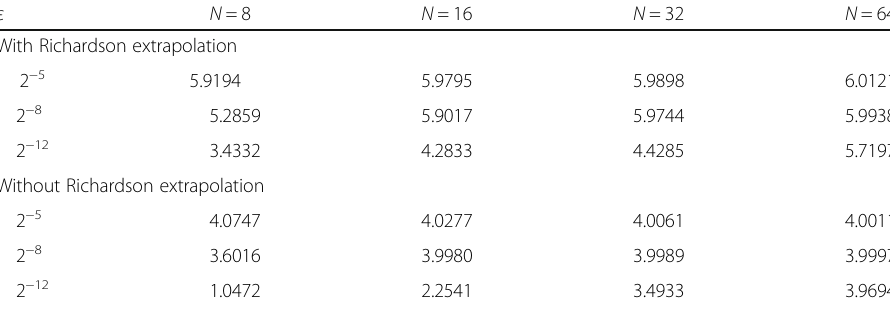
Table 3 Comparison of rate of convergence for Example 1 ε N = 8 N = 16 N = 32 N = 64 With Richardson extrapolation 2 −